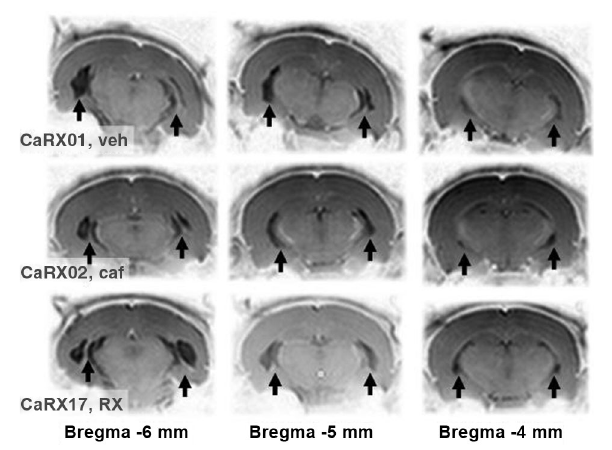
FIGURE 1 | Example of lesions according to MRI . The contrasts of the pictures were inverted so that, opposite to the usual MRI images, the white matter and bone appear clear and the gray matter dark. With this inversion, the lesions replaced by cerebrospinal fluid appear black and the sclerosis, white. They are pointed by black arrows. The pictures in each row correspond to different coronal slices, the approximate anteriority relative to the bregma is indicated below. The three rows show an example of a triplet of lesions. Each row corresponds to one rat before it was treated either with vehicle, veh; or caffeine, caf; or RX821002. The identity of the rat was printed on the left most MRI picture (respectively CARX01,02, and 17) followed by the reference of its experimental group (veh, caf, and